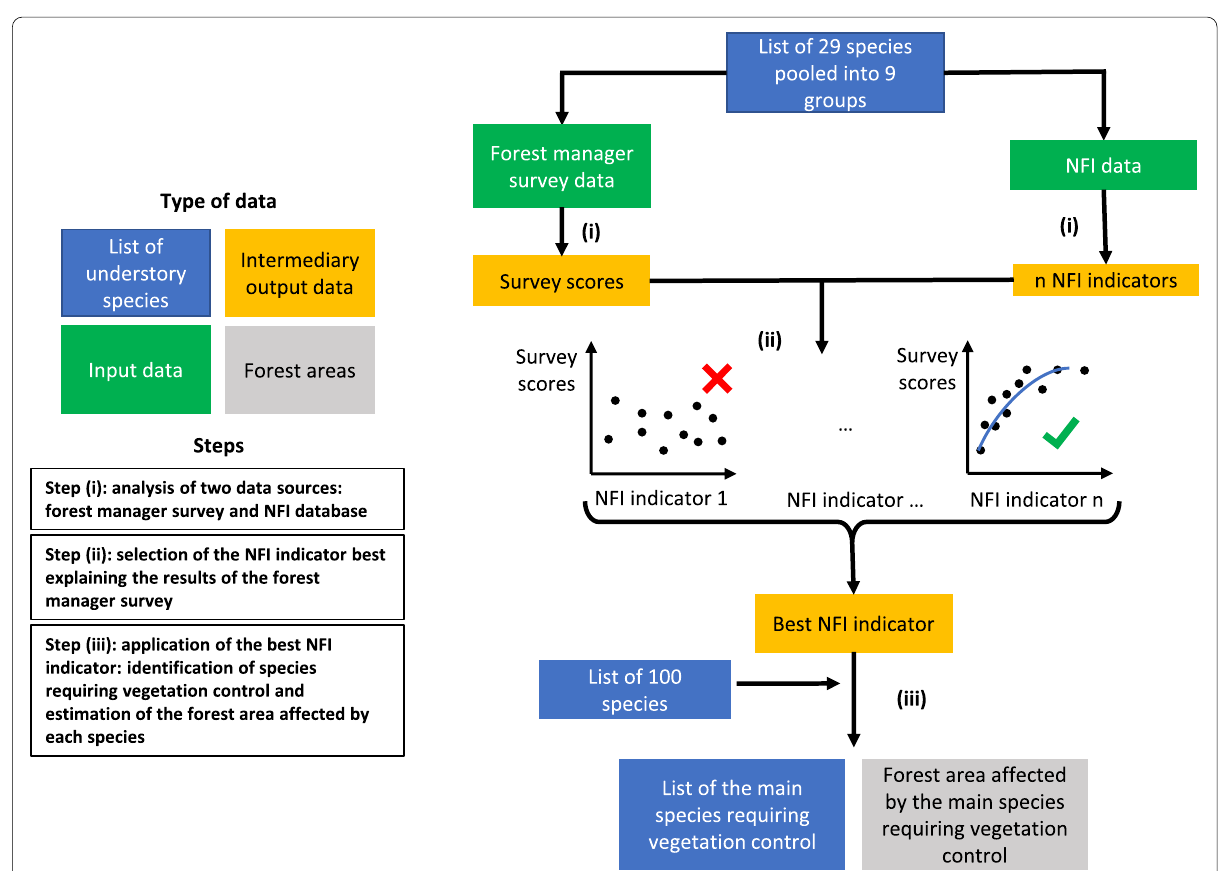
Fig. 1 Workflow of the study. The three steps correspond to the steps described in the “Methods”